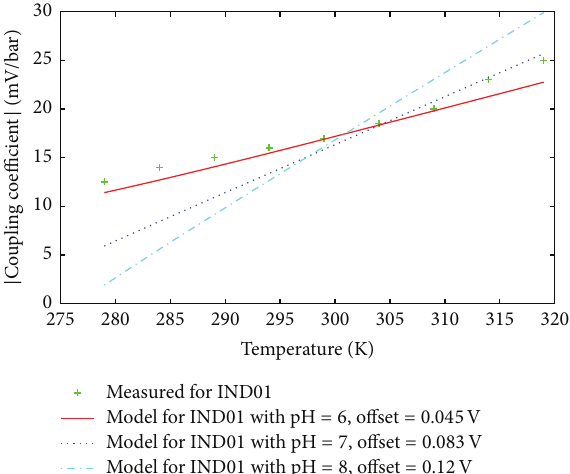
Figure 8: Measured and modeled coupling coefficient as a function of temperature at 5 × 10 −3 M for sample IND01. Three pH values (6, 7, and 8), three corresponding zeta potential offsets ( 𝜁 𝑜 = 0.045 V, 0.083 V, and 0.12 V), and proton surface conductance 𝑐 10 −28 Sm 2 /site were used in the